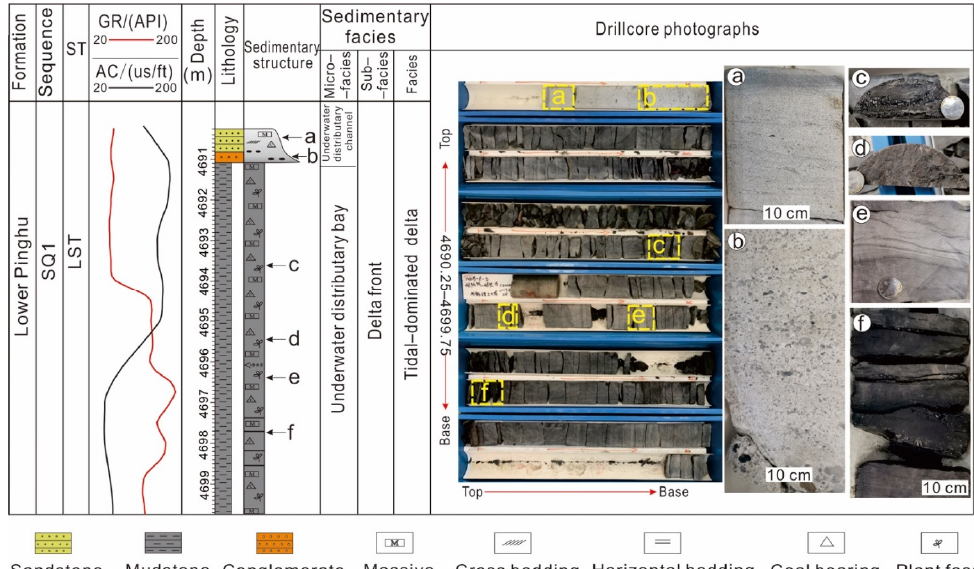
Figure 10. Well log, drill core, and facies interpretations for borehole W-3 from 4065–4050 m in the Xihu Depression. ( a ) 4052.68 m, grey-white fine sandstone with developed mainly parallel bedding with organic matter enriched within laminae; ( b ) 4057.26 m, grey fine sandstone with oblique bedding; ( c ) 4058.72 m, developed herringbone crossbedding; ( d ) 4063.48 m, the scouring surface and contact